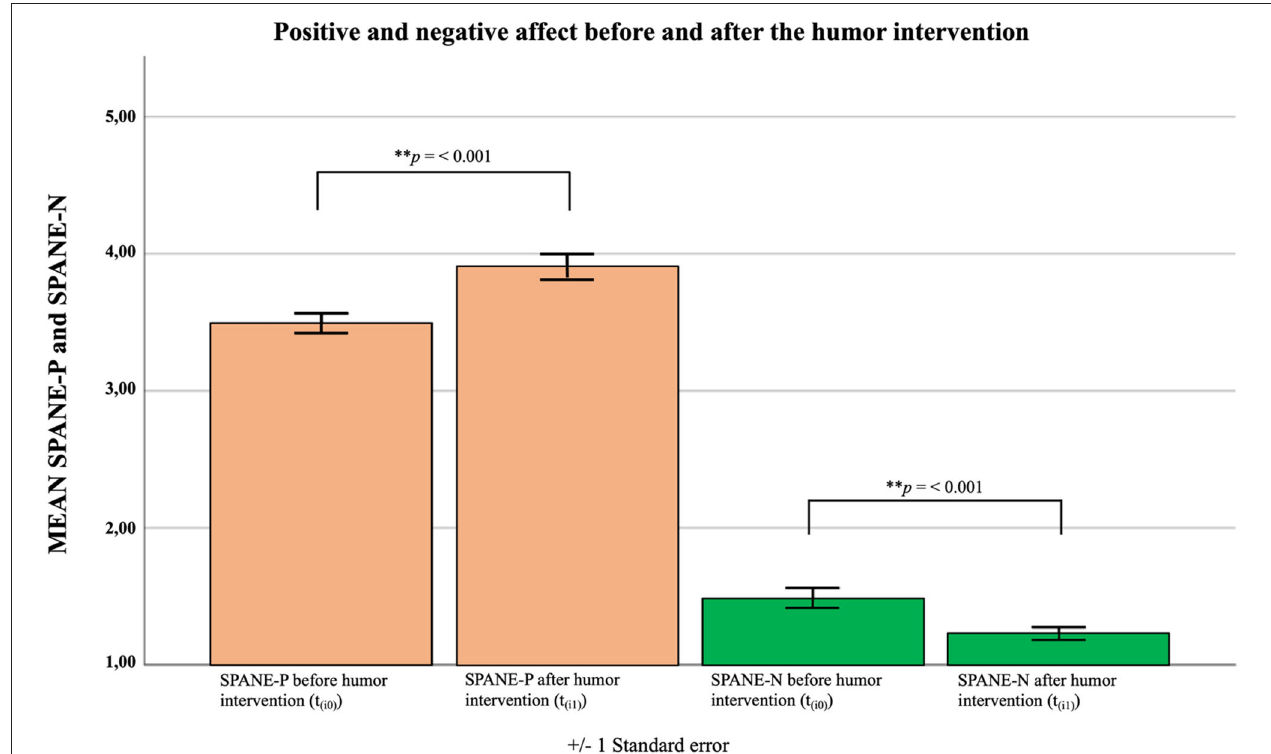
FIGURE 2 | Affect before and after the humor intervention in the intervention group; SPANE-P, positive affect; SPANE-N, negative affect; Measuring points: t (i0) = directly before the humor intervention; t (i1) = directly after the humor intervention.